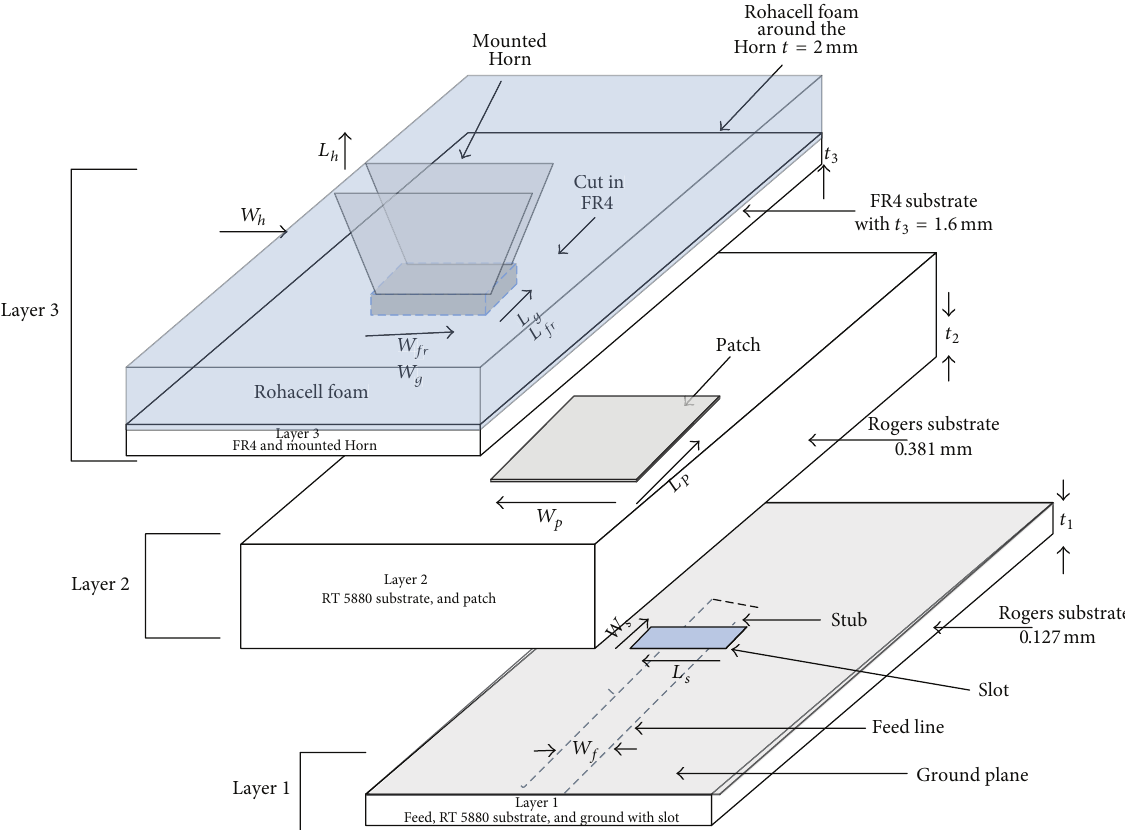
Figure 1: Exploded view of proposed multilayer ACMPA with mounted